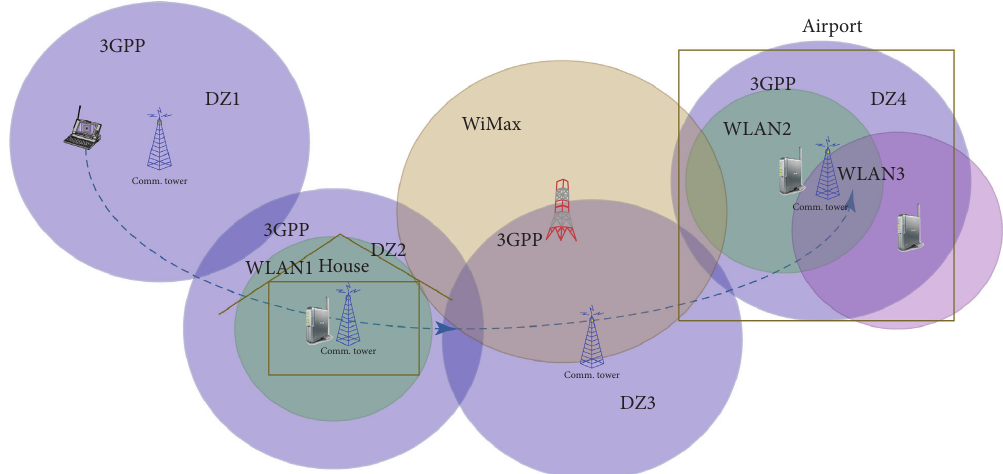
Figure 3: The proposed use case simulation scenario.